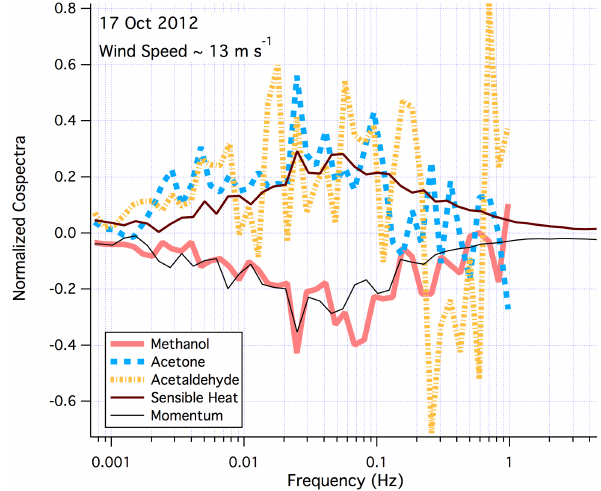
Figure 3. Cospectra of methanol, acetone, acetaldehyde, sensible heat and momentum with the vertical wind velocity on a day of relatively high winds. Each cospectrum is normalized to the respec- tive flux magnitude. Cospectra of heat, momentum, and methanol followed the expected spectral shape, while those of acetone and acetaldehyde were distorted at frequencies above 0.1 Hz, likely due to contamination from the plastic